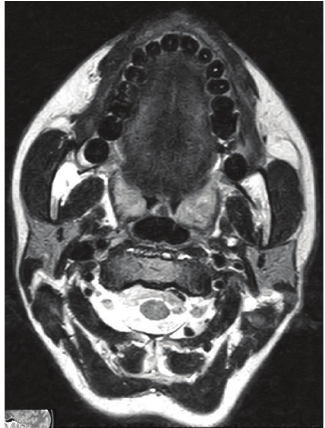
Figure 4: MRI showed the lesion with signal reduction in the sequences with fat suppression.